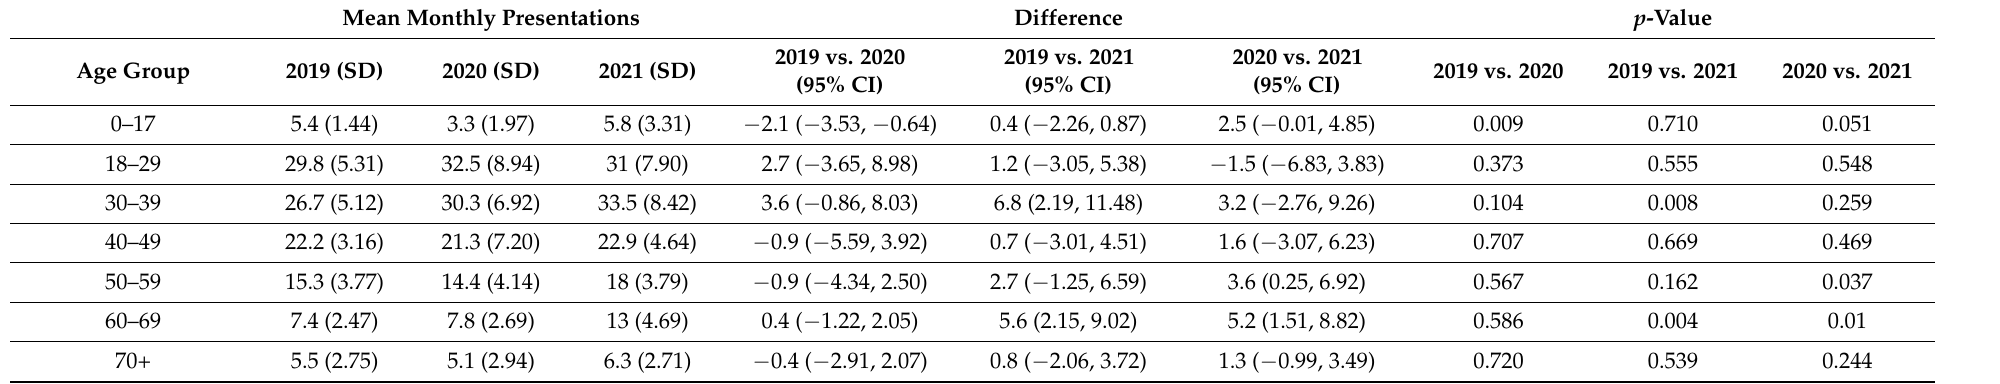
Table 2. Comparison of mean monthly presentations for age group, sex, nationality, and admission